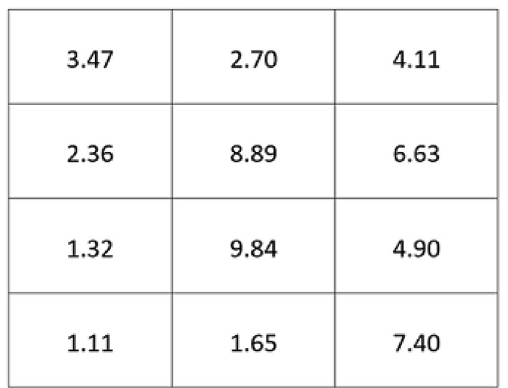
Figure 1. Example of a matrix with 12 three-digit numbers. Respondents were instructed to detect the two numbers that summed up to 10 (i.e., 8.89 and